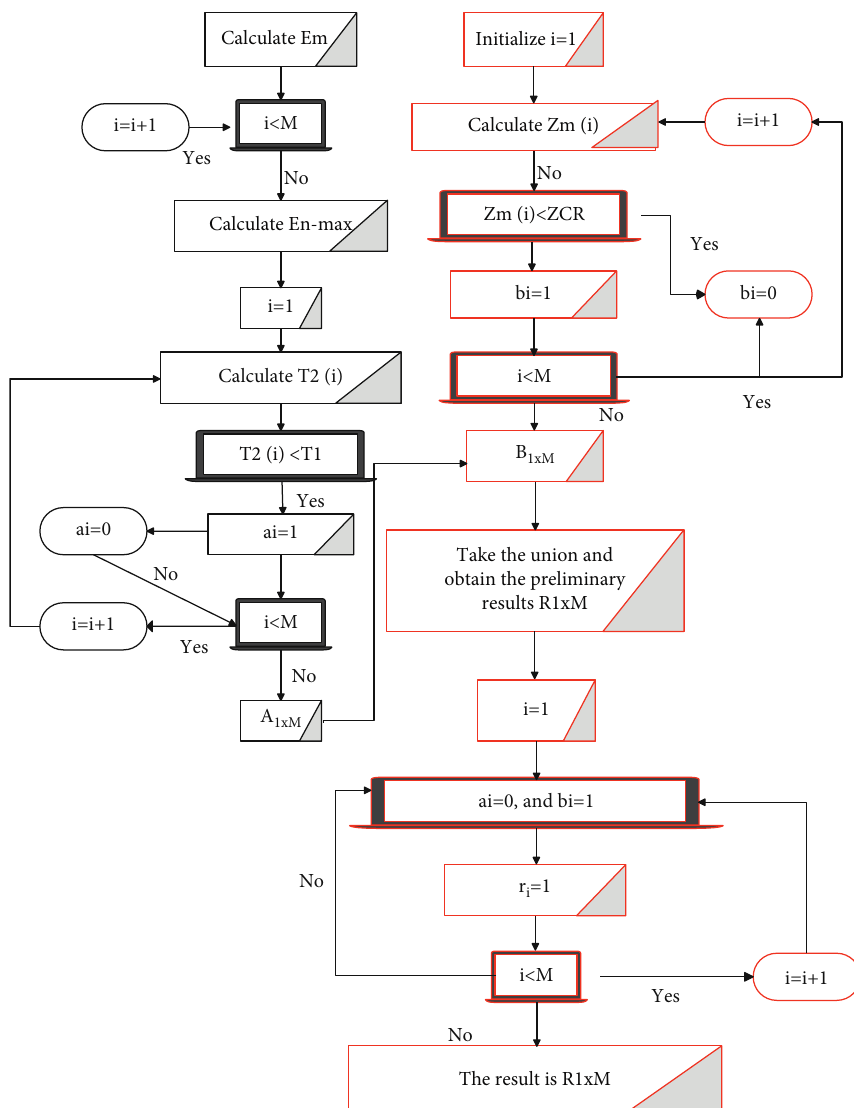
Figure 4: Flow chart of two-stage fusion method of energy-zero-crossing